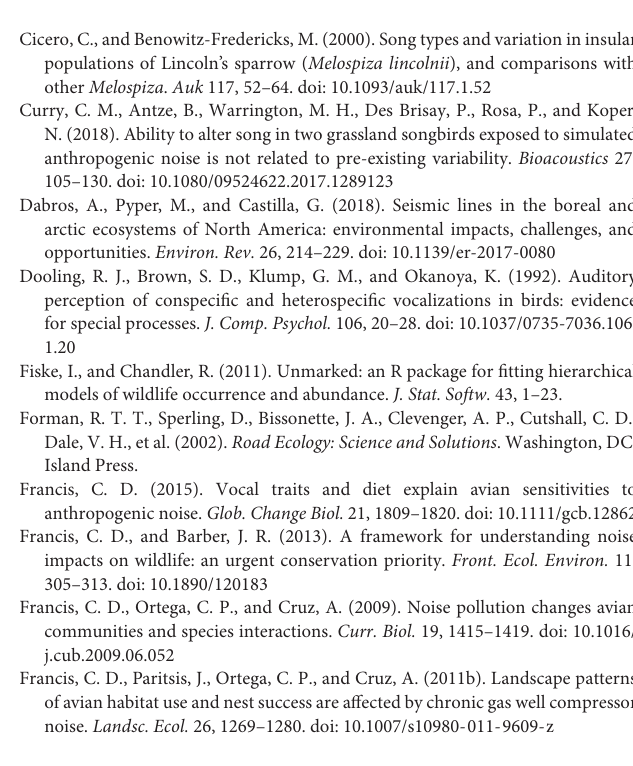
Supplementary Figure 1 | Spatial distribution of average noise levels in the three study sites. Supplementary Figure 2 | Noise measurements at 3 survey days. Supplementary Figure 3 | Correlation of 500 Hz and 1000 Hz noise levels using Raven Pro and Kaleidoscope